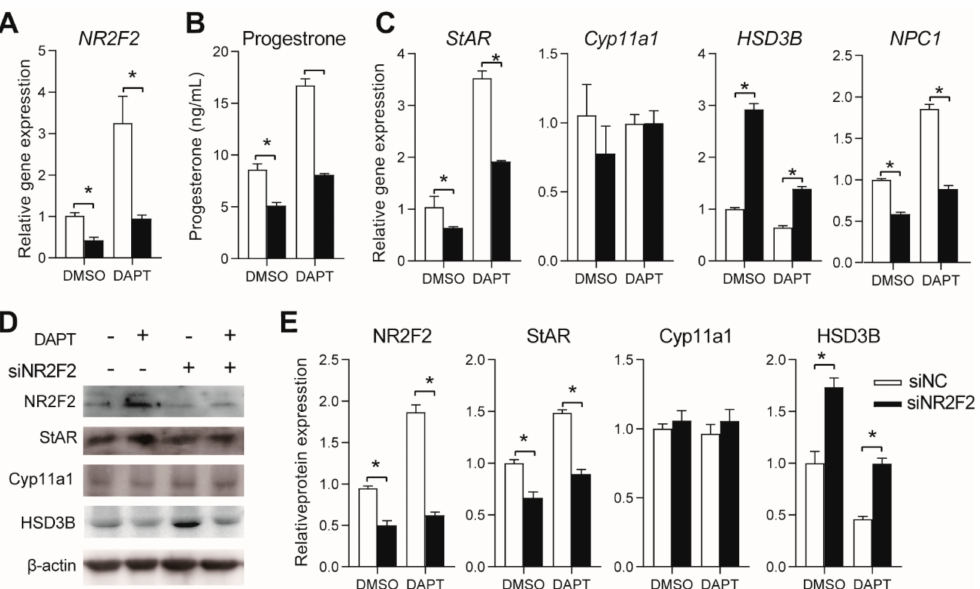
Figure 5. E ff ects of NR2F2 knockdown on progesterone biosynthesis. ( A ) gene expression of NR2F2 after siRNA transfection; ( B ) E ff ects of NR2F2 knockdown on progesterone secretion; ( C ) gene expression of key factors (StAR, Cyp11a1, HSD3B, and NPC1) involved in progesterone biosynthesis; ( D , E ) protein expression of NR5A2, StAR, Cyp11a1, and HSD3B. Primary pGCs were transfected with NR2F2